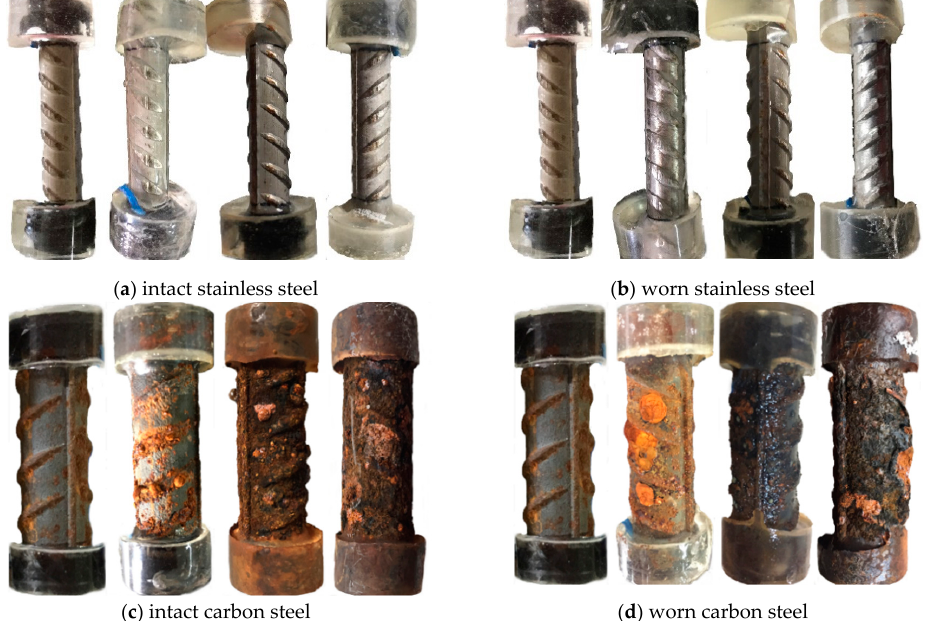
Figure 12. Corrosion state of intact and worn stainless and carbon steels after 0, 10, 90 and 160 days’